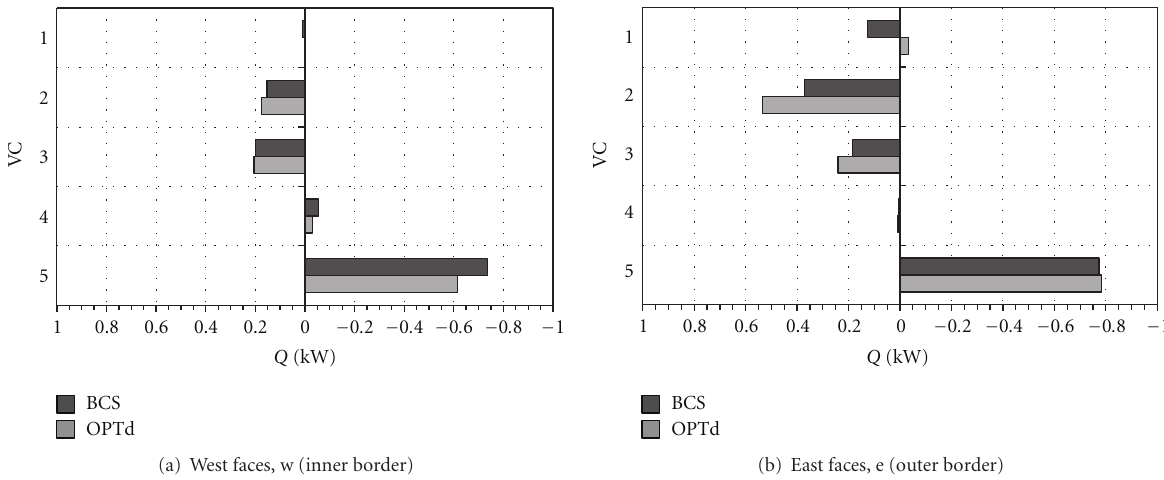
Figure 9: Enthalpic flow rate predictions across West (inner border) and East (outer border) of the air curtain control volumes, per unit length—OPTd case